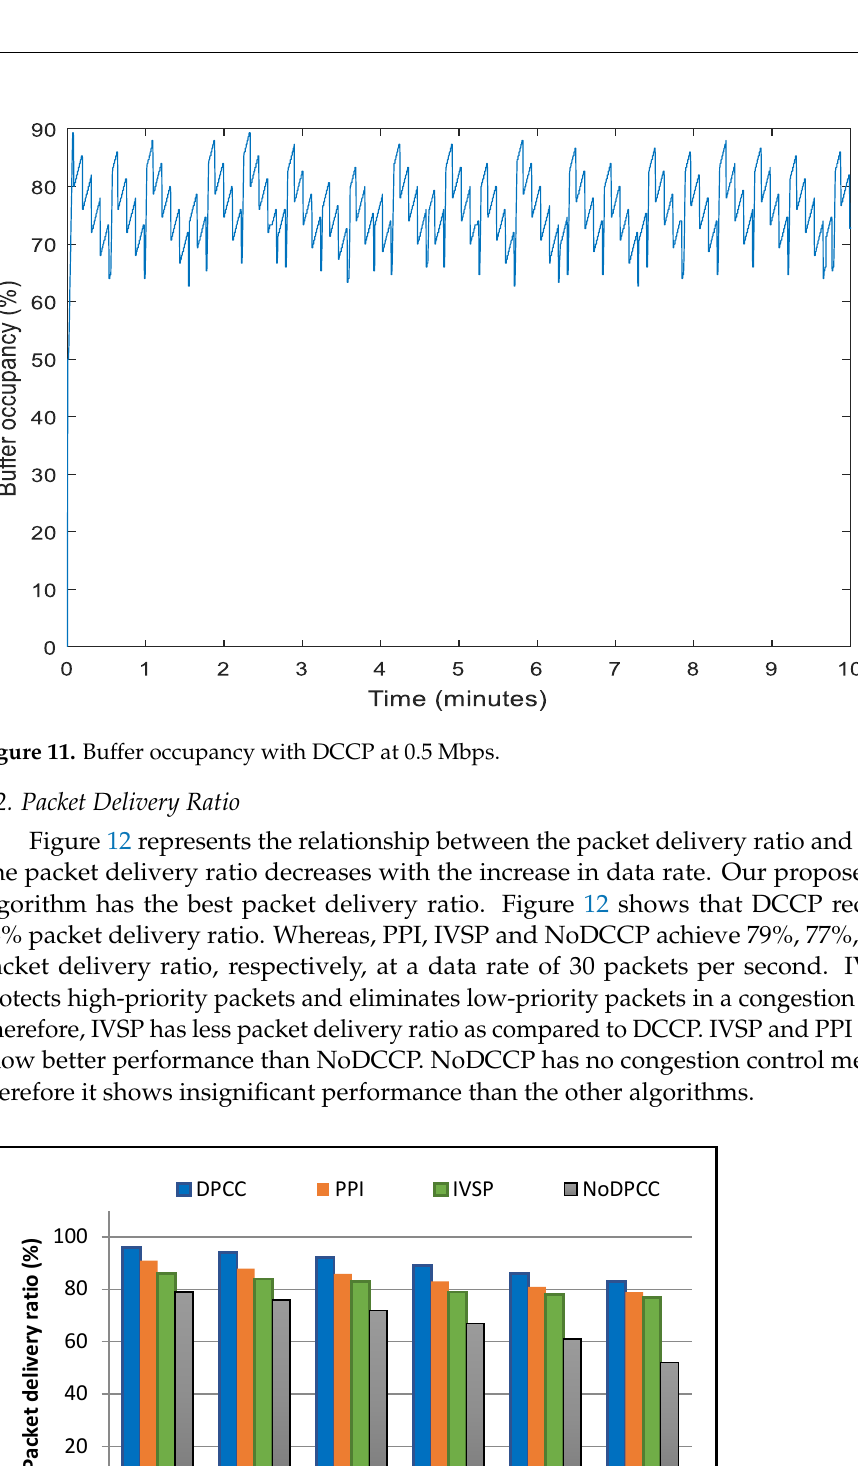
Figure 10. Buffer occupancy with DCCP at 0.2 Mbps.